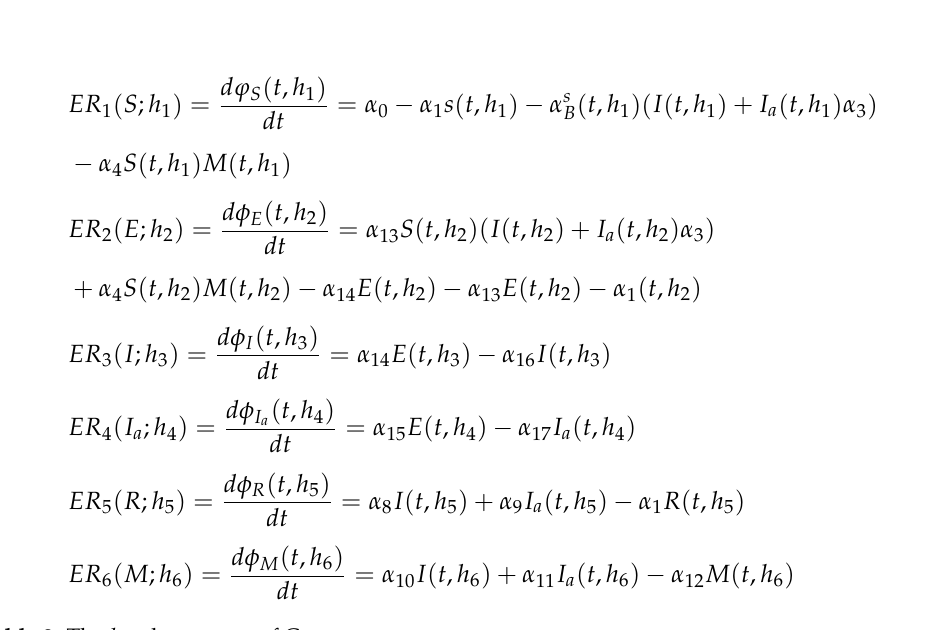
Table 2. The h values range of Compartments.